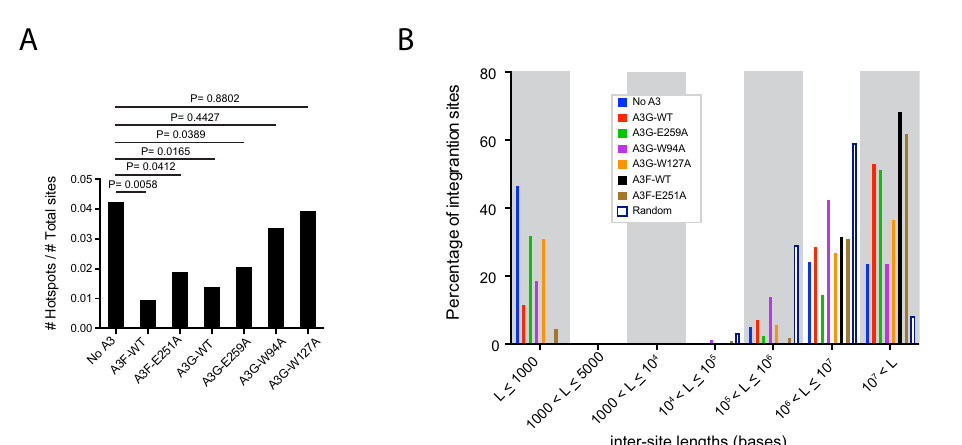
Fig. 5| A3Fand A3G reduce the number ofintegrationhotspotsand clustering of sites. A Analysis of integration site hotspots. A hotspot was de fi ned as a 1kb window in the genome hosting 4 or more unique integration sites. Integration hotspots are shown as a proportion of total integration sites from CEM-SS cells infected with HIV-1 produced in the presence of no A3F or A3G ( “ No A3 ” ) control (bluebars),orfromcellsexpressingA3F-WT(blackbars),A3F[E251A](brownbars), A3G-WT (red bars), A3G [E259A] (green bars), A3G [W94A] (purple bars), or A3G